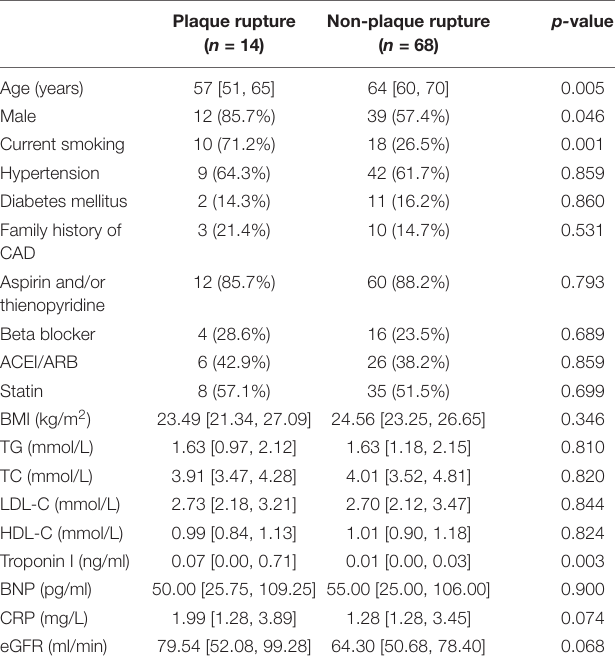
TABLE 1 | Baseline demographic and clinical characteristics of patients with or without plaque rupture. Plaque rupture Non-plaque rupture ( n = 14) ( n =